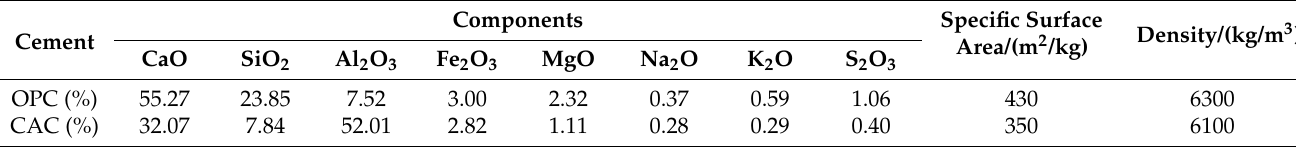
Table 2. Components and physical properties of